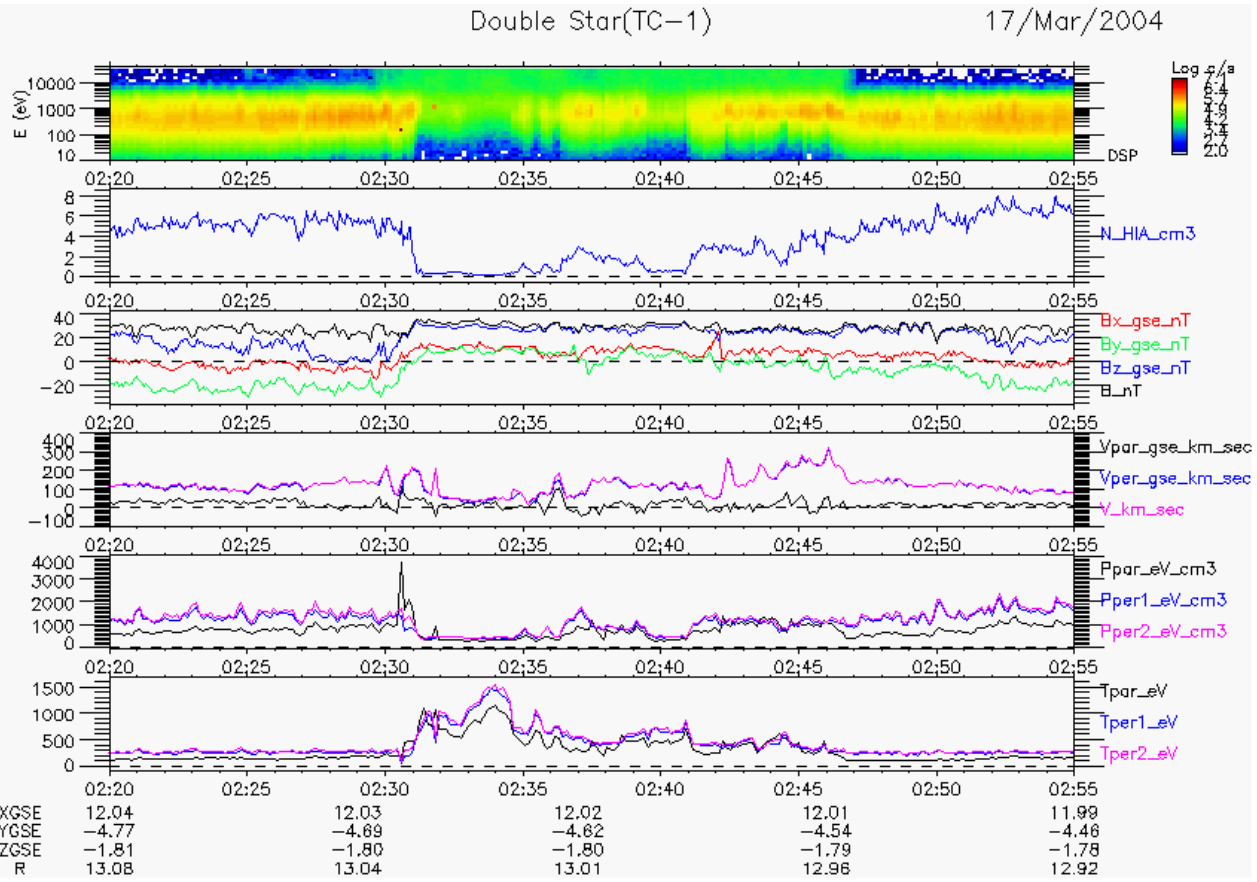
Fig. 4. Magnetic field and hot ion parameters from TC-1. From top to bottom, (a) hot ion time-energy spectrogram, (b) hot ion density, (c) components of the magnetic field, (d) ion bulk velocities. (e) and (f) components of hot ion pressure, and temperature,